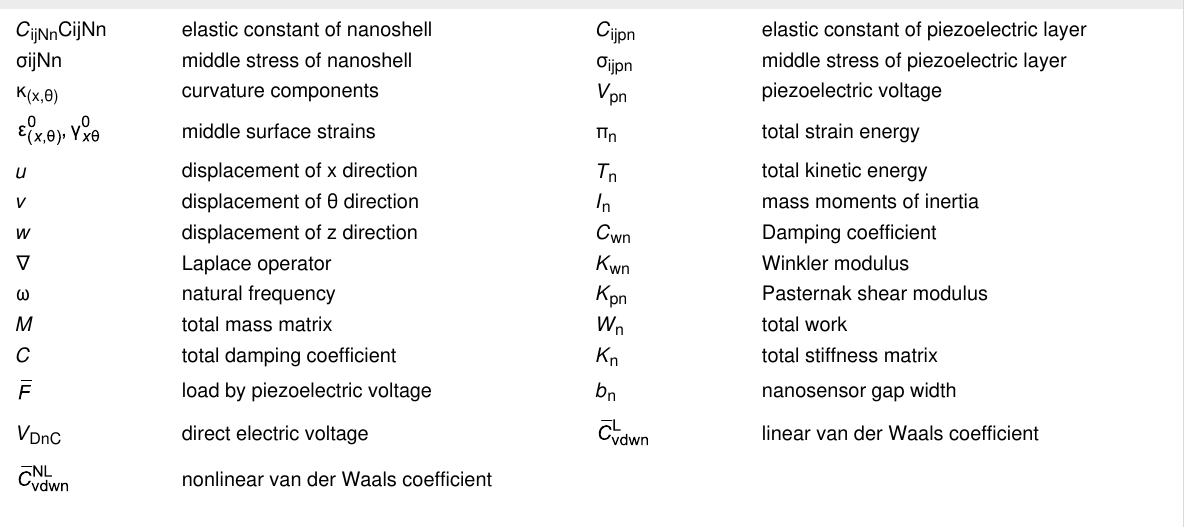
Table 1: Notation and symbols used in this work. (continued)